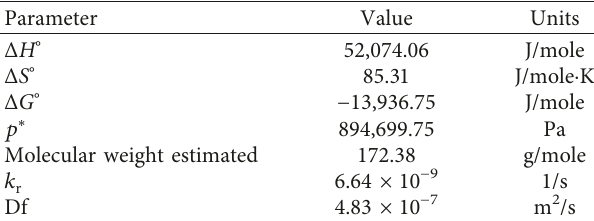
Table 3: Not Reacted Core model results.